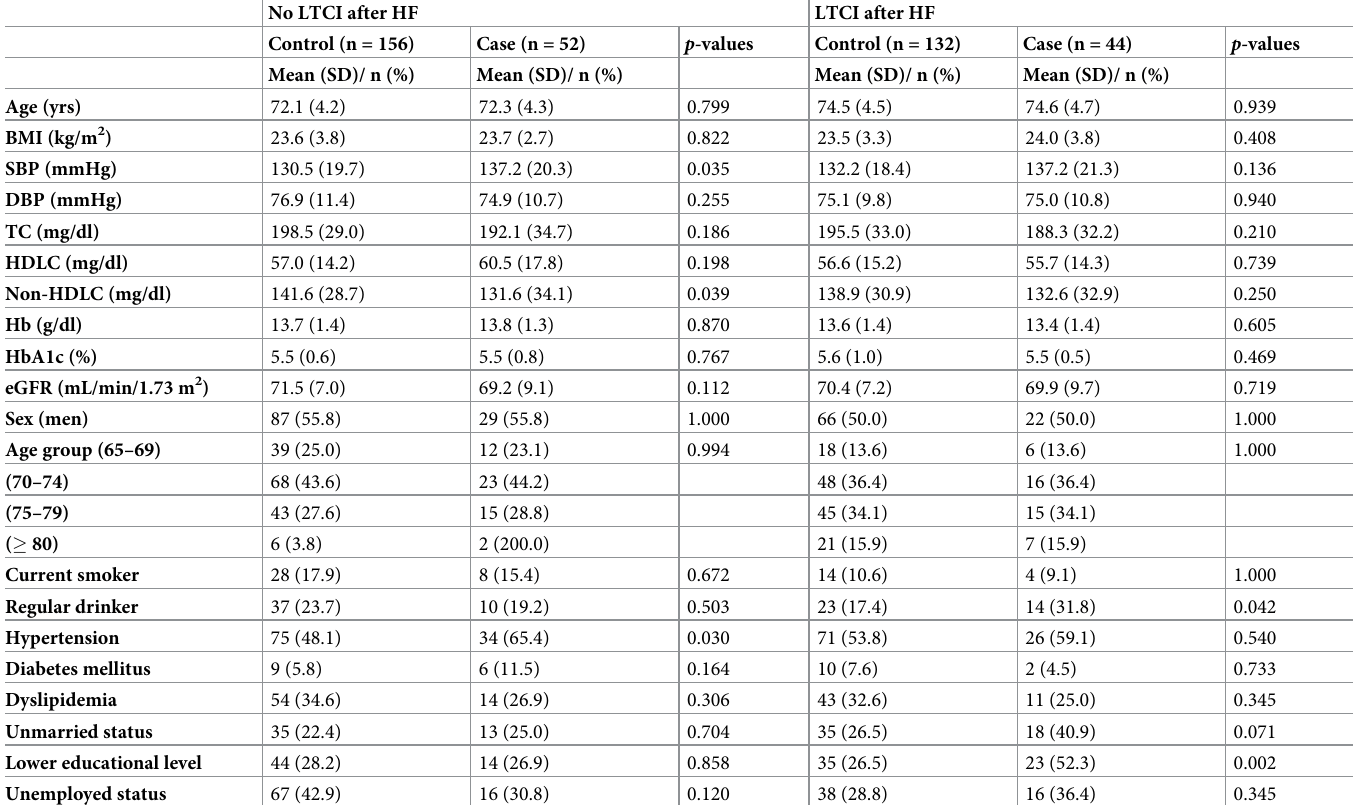
Table 1. Baseline